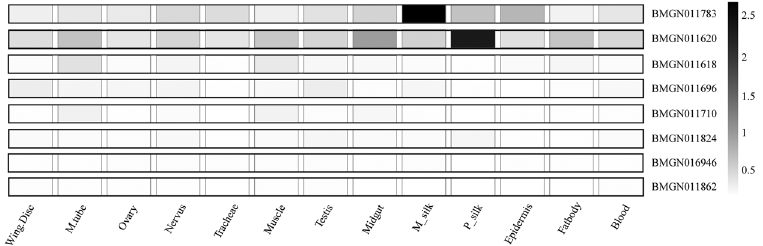
Figure 3. Confirmation of the spatial expression pattern of selected genes. M_tube is short for Malpighian tubes; M_silk and P_silk means the middle silk gland and the posterior silk gland